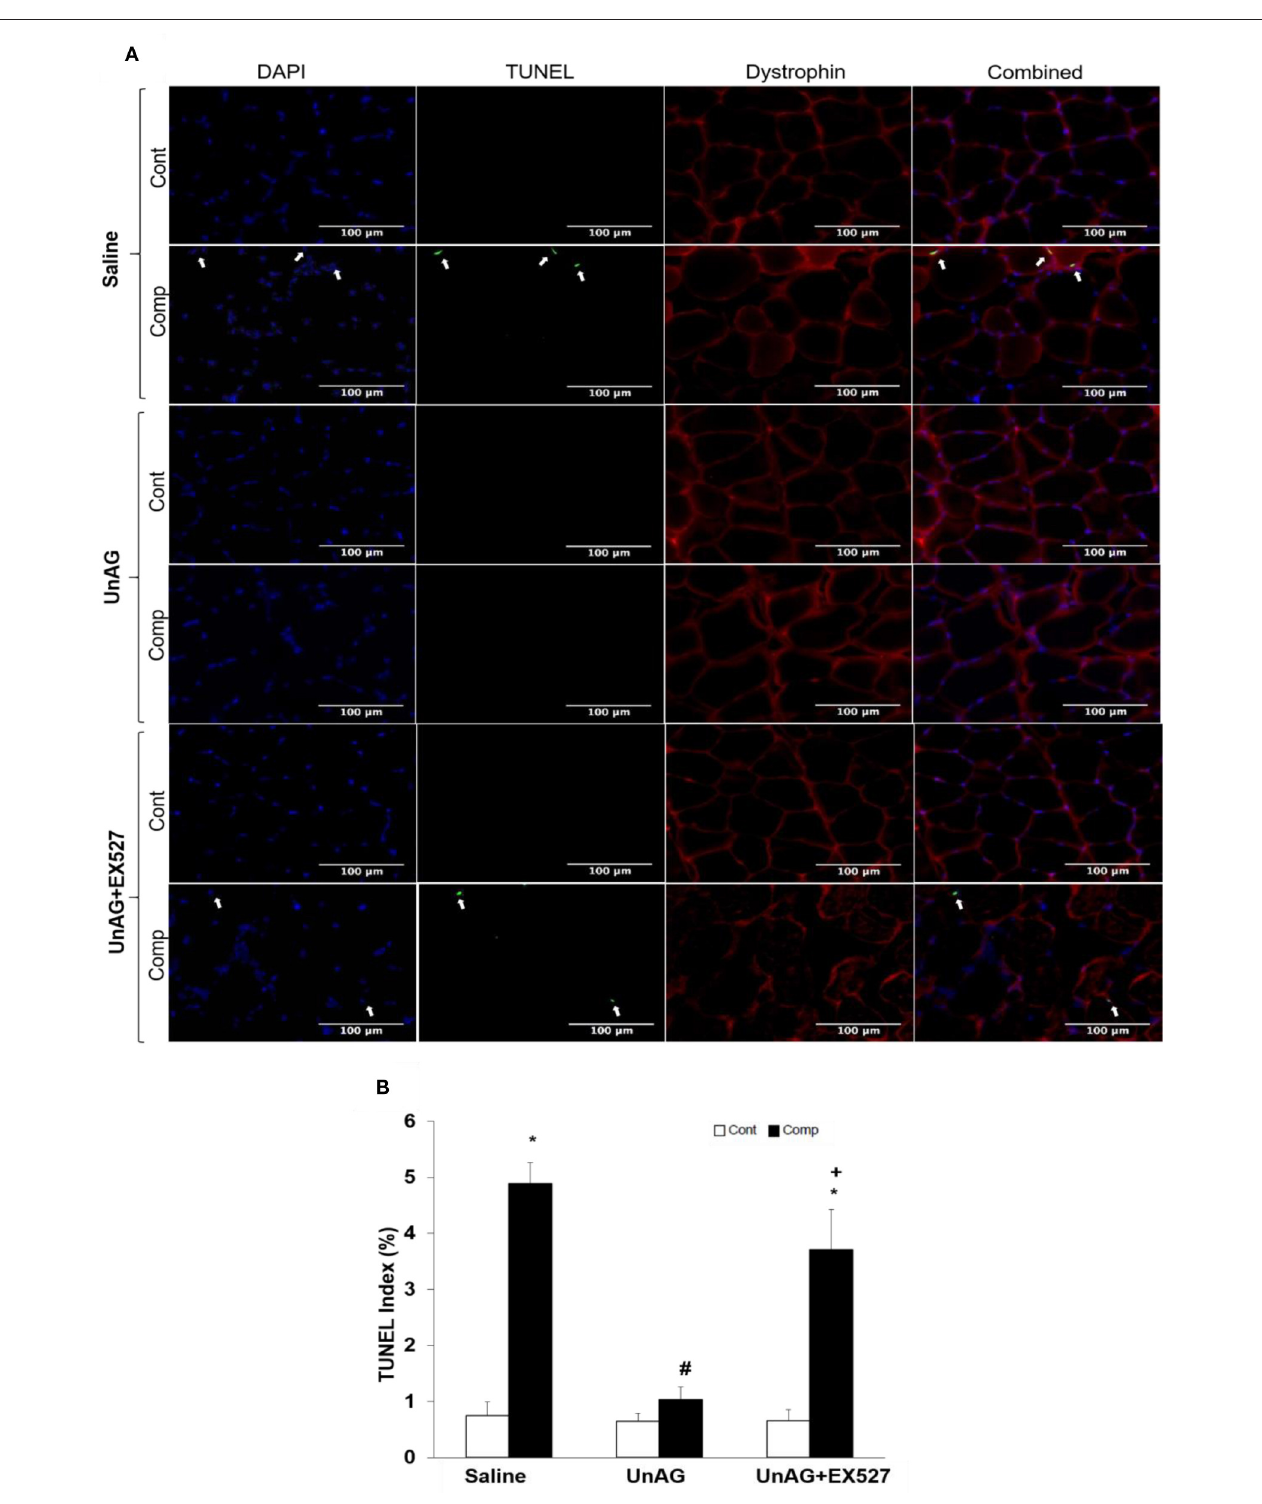
FIGURE 2 | TUNEL and dystrophin staining. Apoptotic nuclear DNA breaks in muscle tissue were measured using the technique of TUNEL staining (A) and were expressed as TUNEL index (B) . Representative images of TUNEL and dystrophin staining of compressed and uncompressed muscles (A) . Immunofluorescence labeling of dystrophin (red) was performed to identify the localization of the TUNEL-positive nuclei (green) with regard to muscle sarcolemmal membrane and nuclei